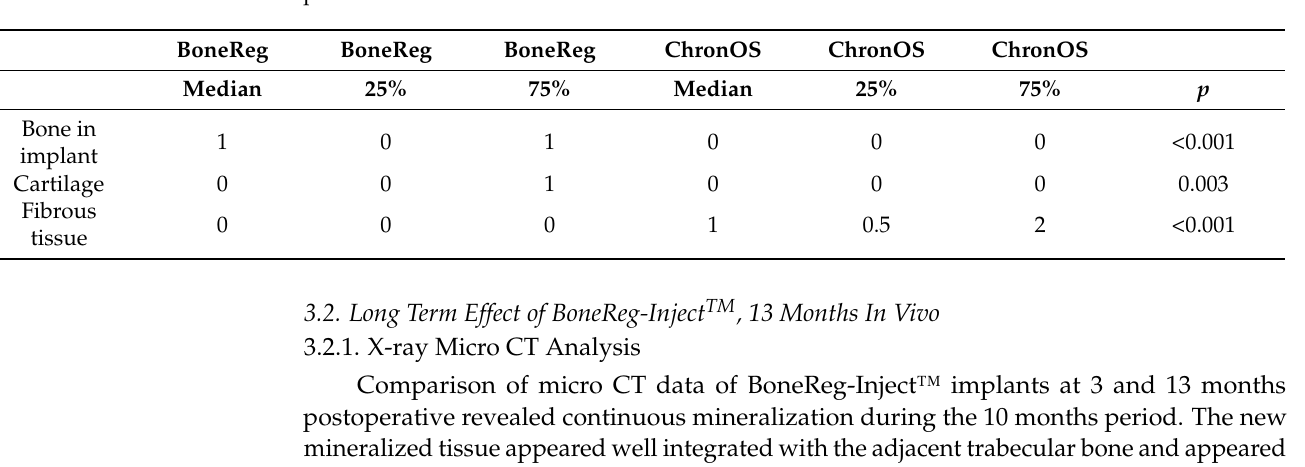
Table 2. Mann-Whitney rank sum test results. A total comparison of 25 sheep tibia, 13 of BoneReg- Inject™ and 12 of chronOS Inject ® implants. When ranking histological samples (0, 1 or 2)